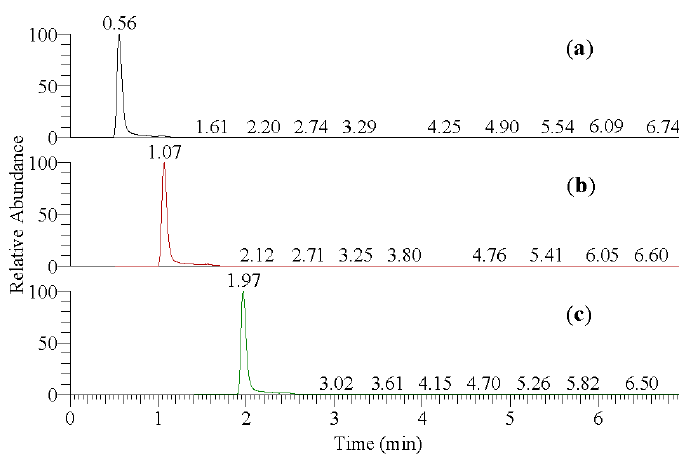
Figure 2. Selected ion monitor (SIM) chromatograms of carbendazim using different columns: ( a ) C 18 column; ( b ) C 8 column; and ( c ) Waters High Strength Silica (HSS) T3 column. Int. J. Mol. Sci. 2017 , 18 , 2333